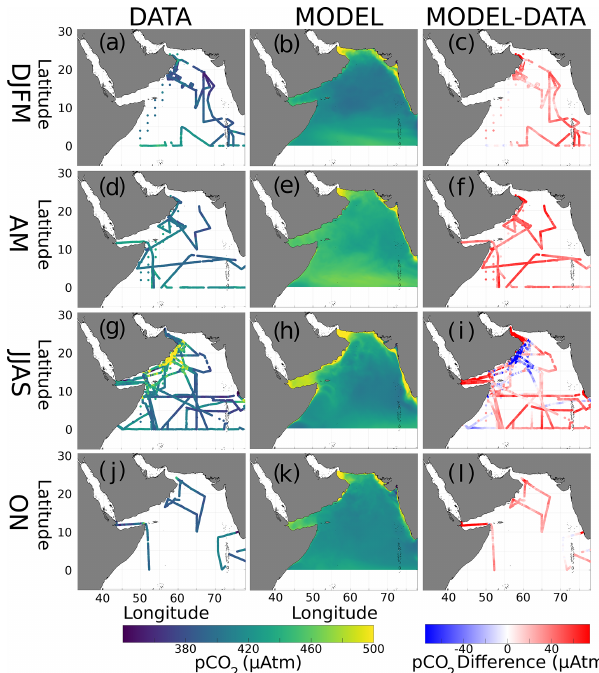
Figure 3. Seasonal surface p CO 2 (µatm) from data (left column, a,d,g,j ) and the model (middle, b,e,h,k ), as well as their differ- ences (right, c,f,i,l ). Plots are arranged by season: winter monsoon (DJFM, a–c ), spring intermonsoon (AM, d–f ), summer monsoon (JJAS, g–i ), and fall intermonsoon (ON, j–l ). Table 3. Mean and standard deviation (in parentheses) of annual and seasonal surface p CO 2 (µatm) in both the merged dataset and model. Data